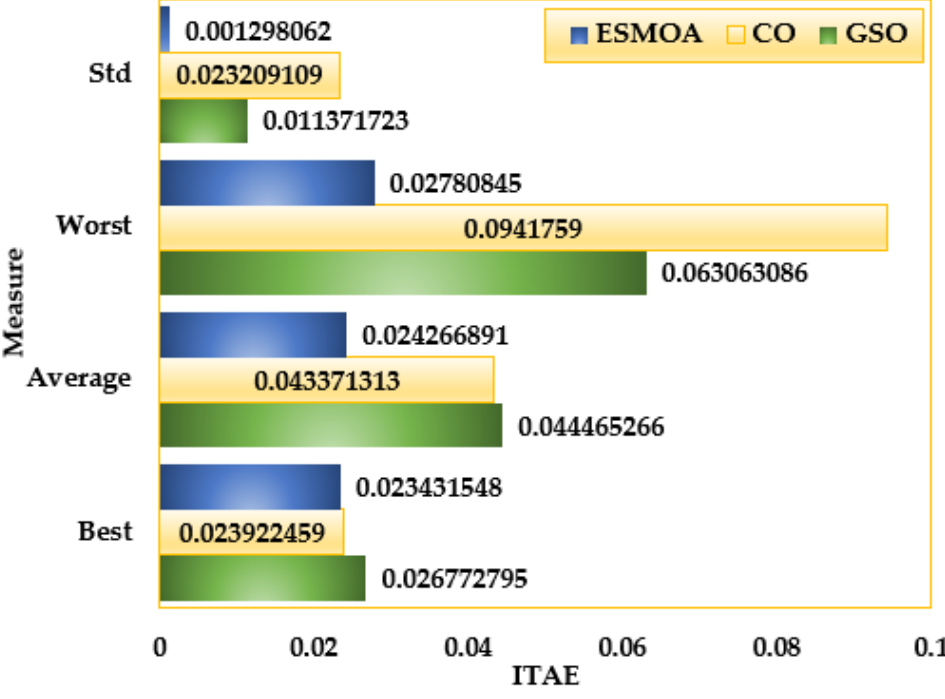
Figure 7. Statistical measures for CO, GSO, and the proposed ESMOA for Case 1.